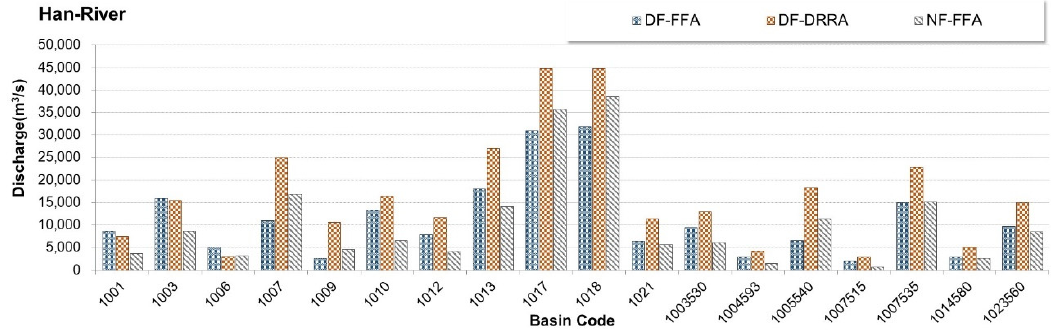
Water 2020 , 12 , x FOR PEER REVIEW Figure 9. The 100-year design floods of Han River basin. Figure 9. The 100-year design floods of Han River basin.